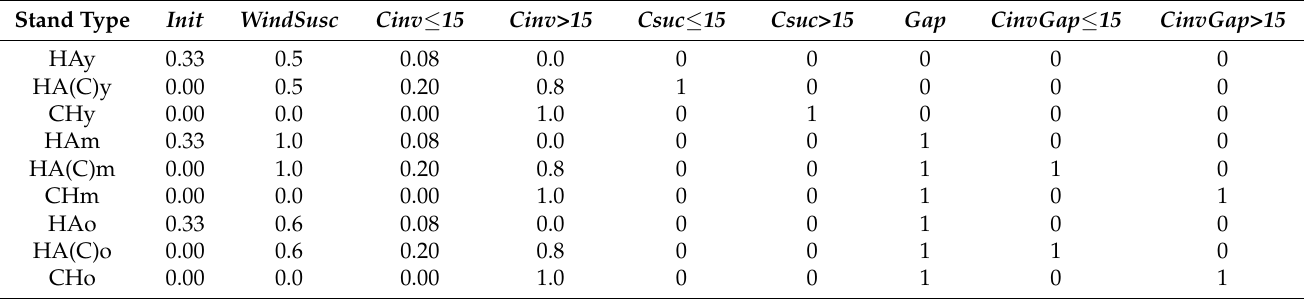
Table 4. Probability values used to define the transitions in the scenario of base case of multiple pathway model. Stand Type